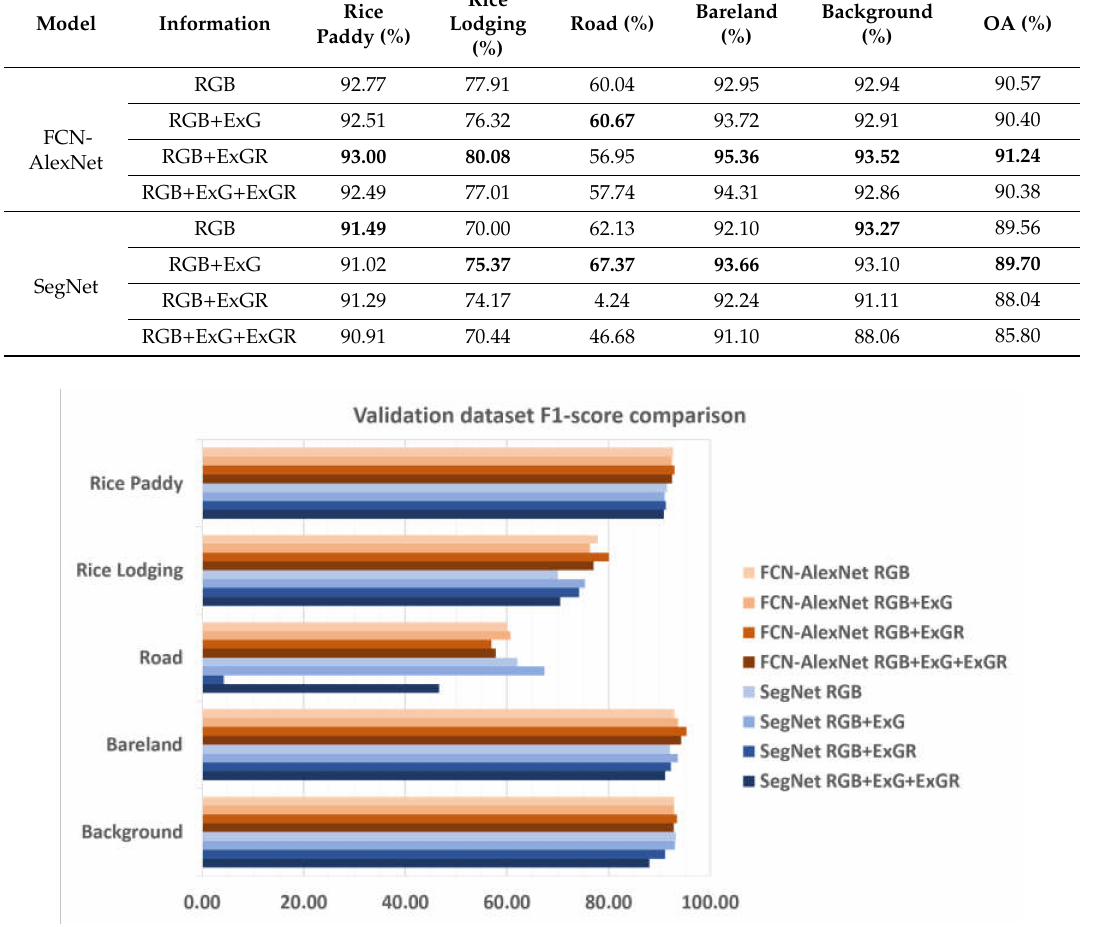
Figure 8. Performance evaluated by Per-category F1-score for the validation